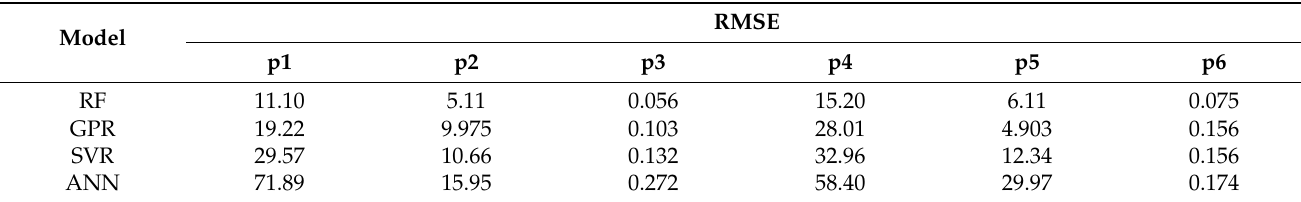
Table 3. Error range for six parameters calculated from four